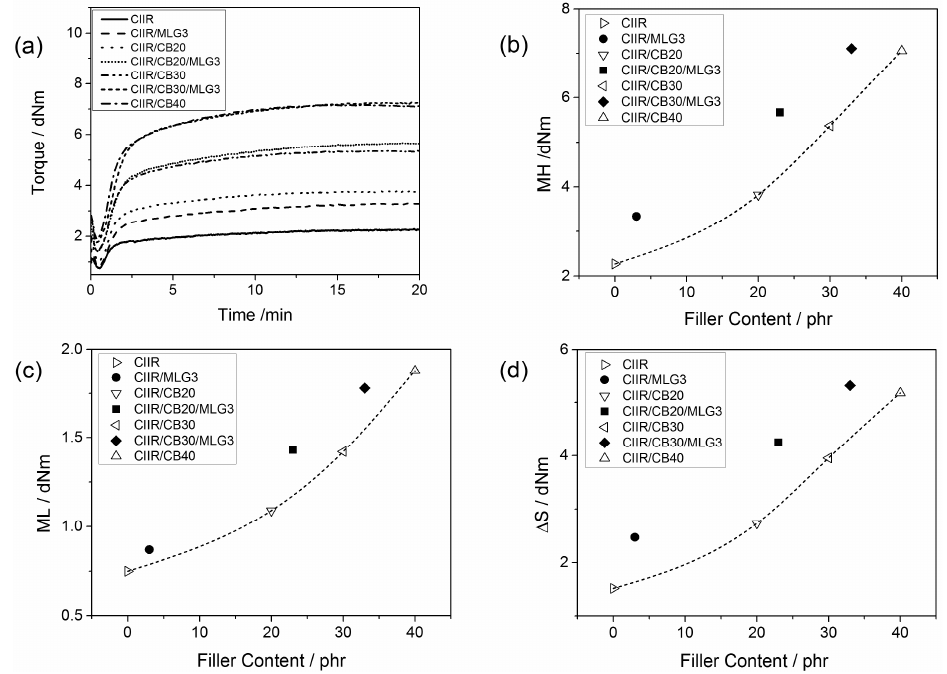
Figure 6. ( a ) Curing curves of CIIR ( chlorine isobutyl isoprene rubber ) and its composites; ( b ) maximum of the torque; ( c ) minimum of the torque; and ( d ) difference between maximum and minimum of the torque as a function of the filler content; the lines are visual guides. Table 3. Curing properties of CIIR and its composites.